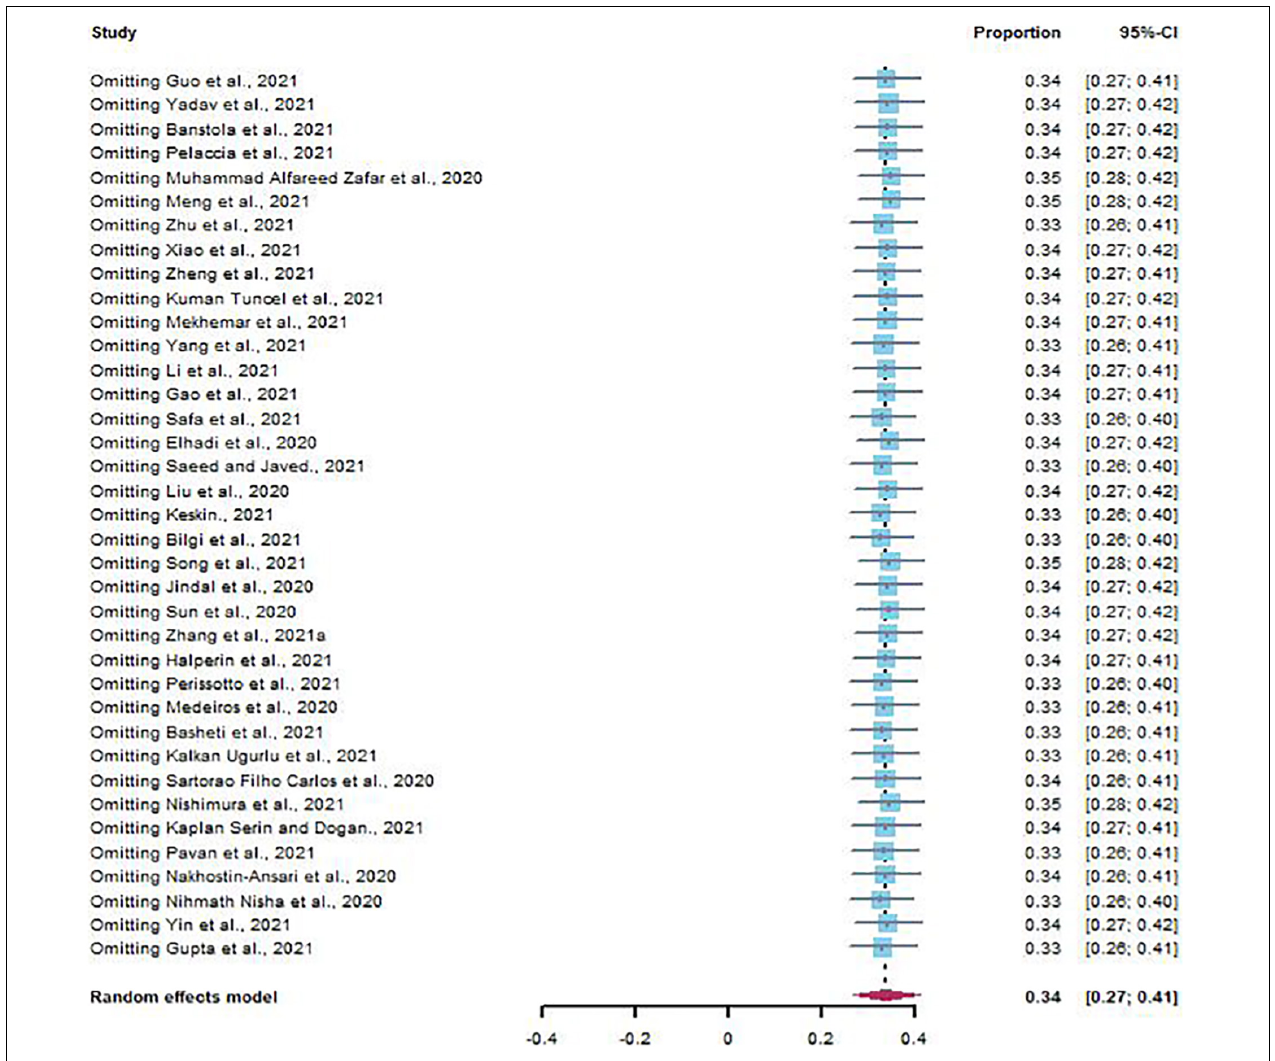
FIGURE 7 | Sensitivity analysis of